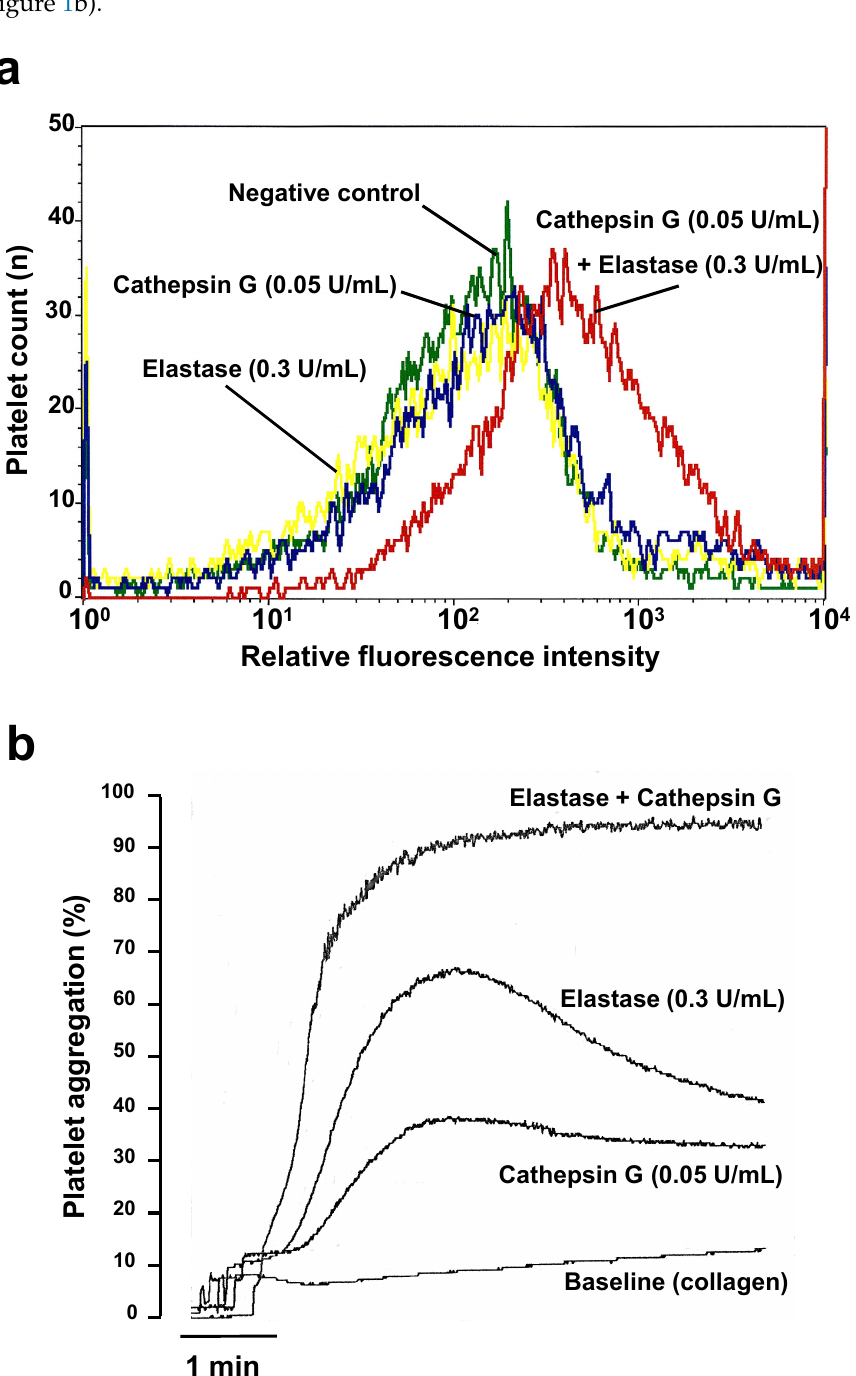
Figure 1. Synergistic effect of low cathepsin G and elastase concentrations on human platelet activa- tion. ( a ) Relative fluorescence histograms for the distribution of activated washed platelets